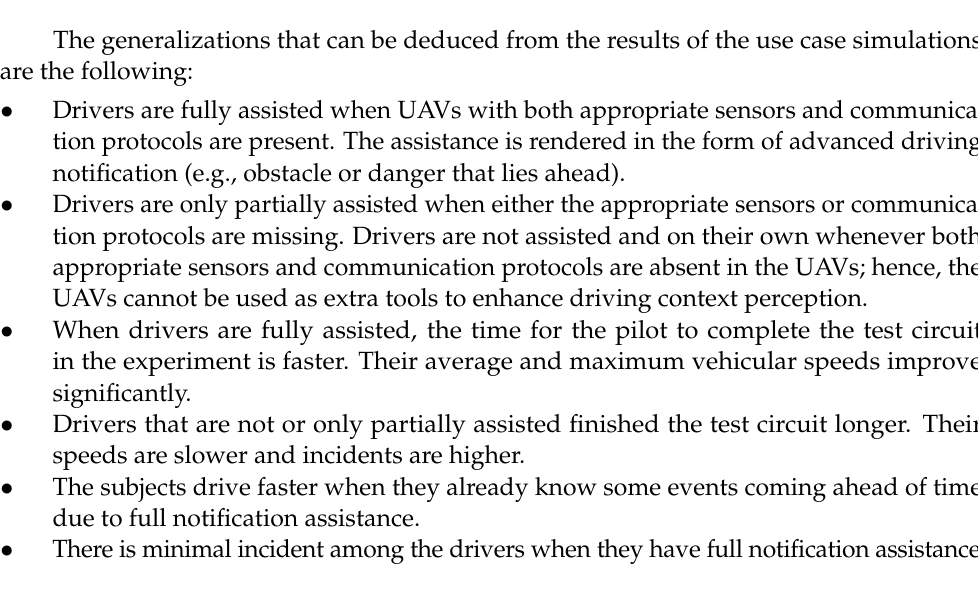
Figure 33. Results of the driving test simulation among test